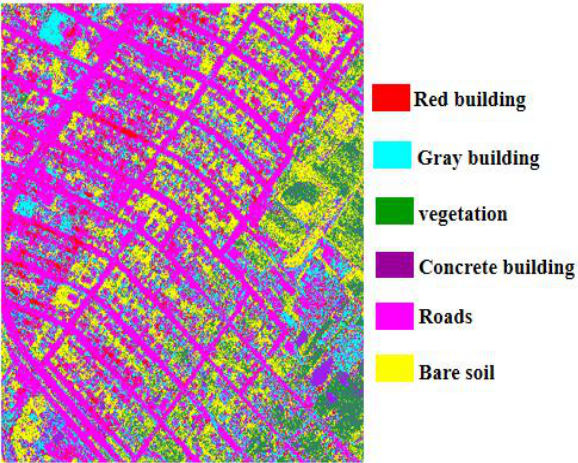
Figure 5. Classification result on original TIR